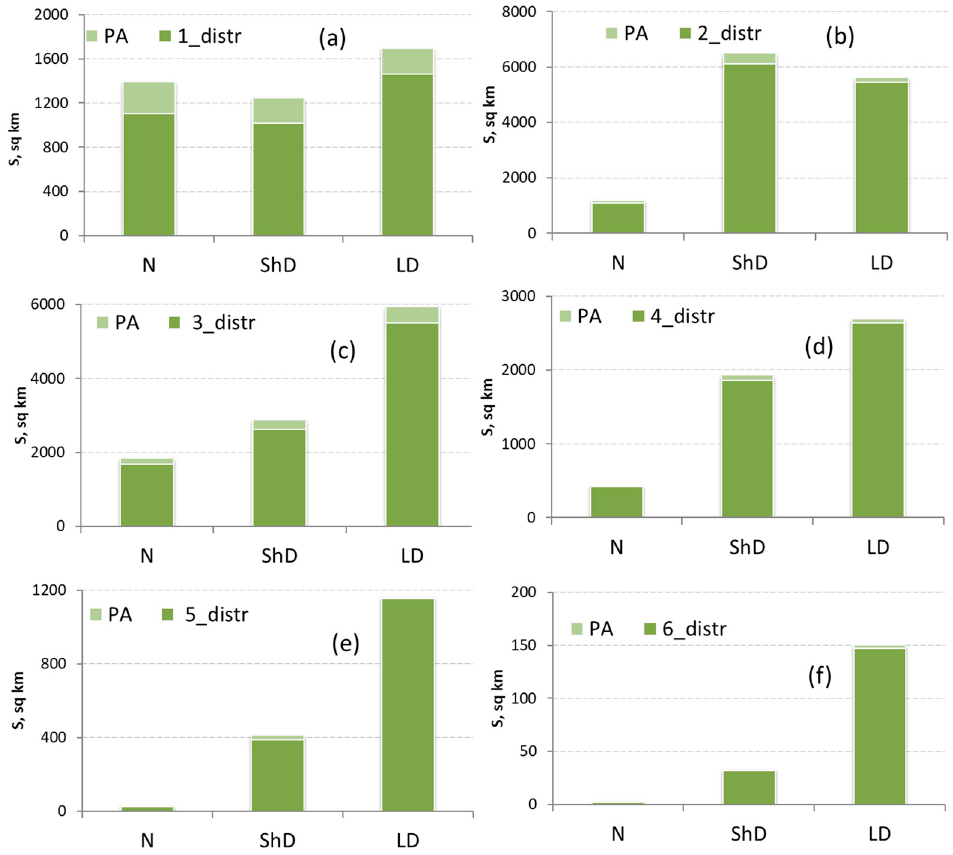
Figure 6. The area of forest communities with different successional statuses within the protected areas (PA) and the district as a whole (distr) (km 2 ). Successional status: 1—natural forests, 2—short-term derivative forests, 3—long-term derivative forests. BDs: ( a )—LT, ( b )—MZ, ( c )—NS, ( d )—PK, ( e )—KZ, ( f )—S.